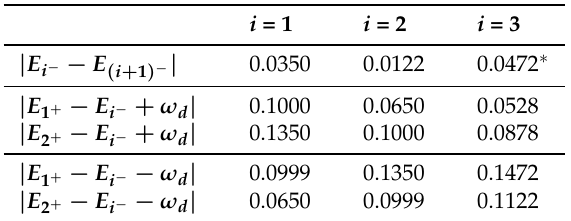
Table 4. Oscillation energies ω (cid:48) [a.u.] of the ATA peaks, dependent on the electronic structure of the atom (2 ω d = 0.20 a.u. is missing in the